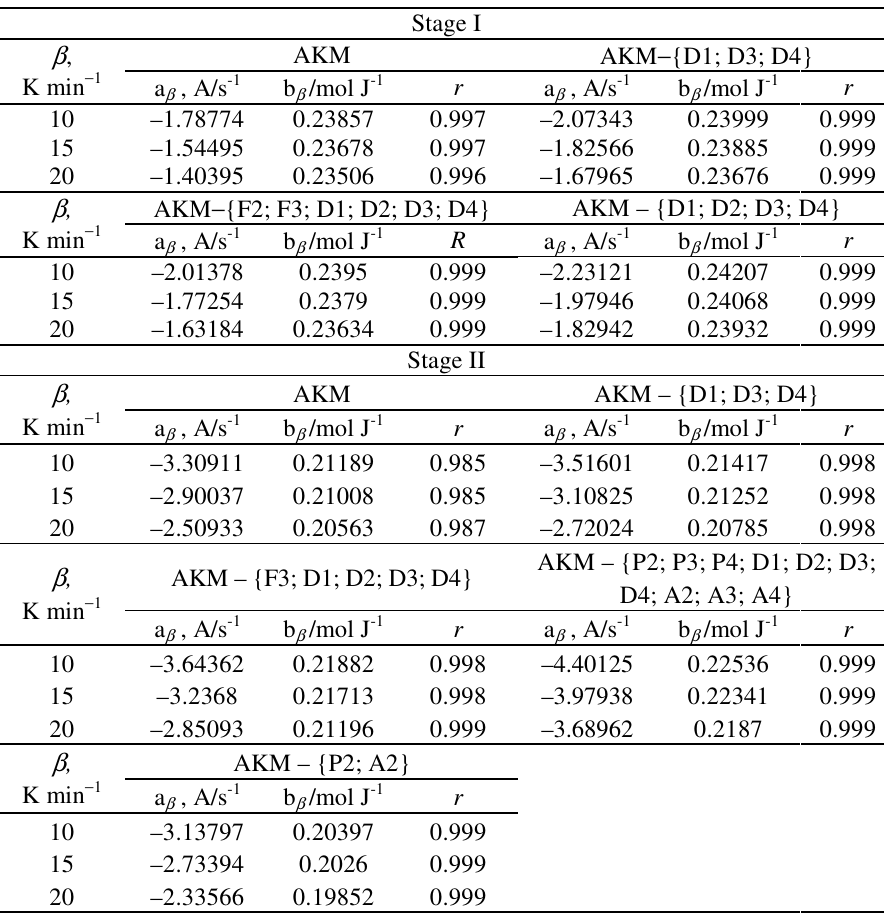
Table 5. Compensation effect parameters for several combinations of kinetic models for the decomposition of